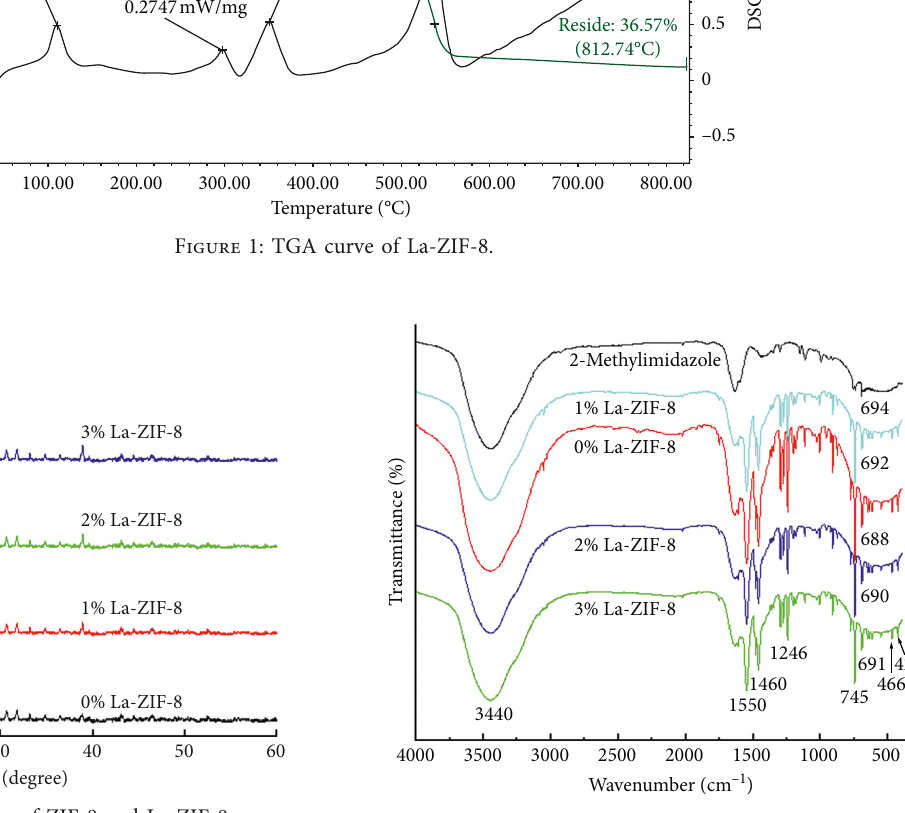
3: FTIR spectra of ZIF-8 and